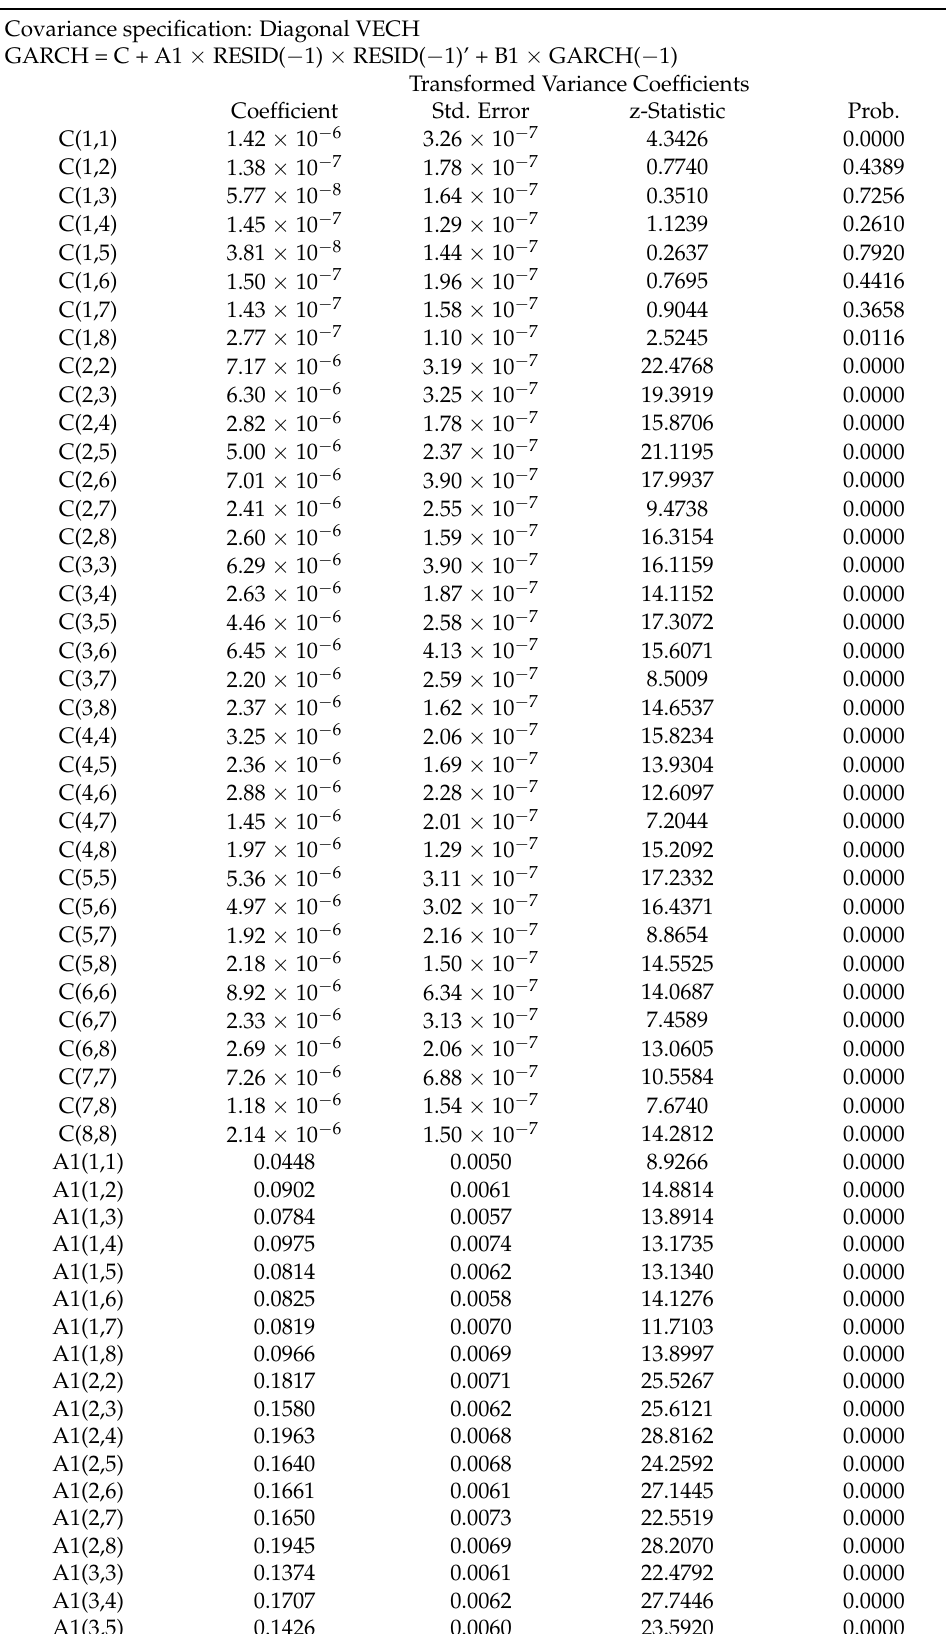
Table A2. D-VECH model results (GOLD-G7 indices). Covariance specification: Diagonal